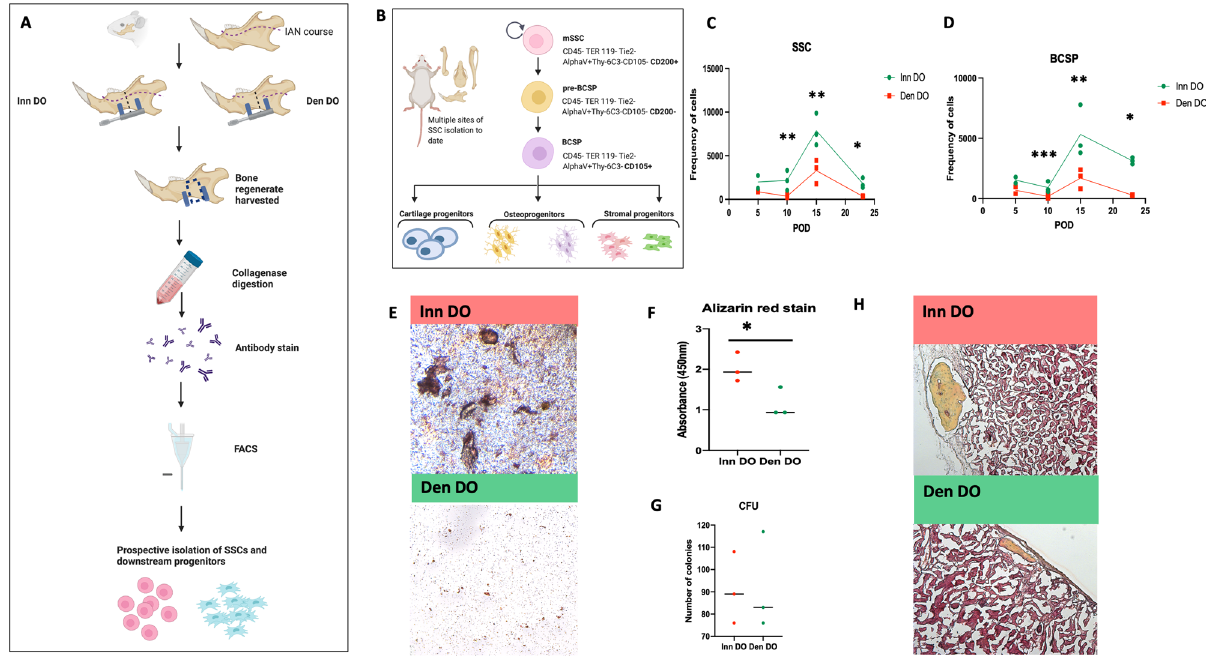
Figure 2. Mandible Skeletal Stem Cell Kinetics and Osteogenic Potential following DO are nerve dependent. ( A ) Experimental schematic: bone regenerate was harvested at multiple timepoints and cells were dissociated for FACS antibody staining and subsequent sorting / analysis. SSCs were then prospectively isolated for in vitro and in vivo analyses. Created with BioRender.com. ( B ) The mouse skeletal stem cell (SSC) is a single cell capable of giving rise to bone, cartilage and bone marrow stroma 14 and has previously been isolated from long bone 14,15 , long bone fractures 17,18 , and mandibles 12,13 . The lineage tree with relevant immunophenotypes of SSC and downstream progenitors are shown. Here, BCSP bone, cartilage and stromal progenitor. Created with BioRender. com. ( C ) Frequency of SSCs isolated using FACS from Inn DO mandibles (red) versus Den DO mandibles (green) at multiple post-operative time-points: (left to right) POD 10, POD 15, POD 23. Here * denotes p < 0.05, ** denotes p < 0.01. ( D ) Frequency of BCSPs isolated using FACS from Inn DO mandibles (red) versus Den DO mandibles (green) at multiple post-operative time-points: (left to right) POD 10, POD 15, POD 23. Here * denotes p < 0.05, ** denotes p < 0.01, *** denotes p < 0.001. ( E ) Alizarin red staining of mSSCs isolated from Inn DO (red, above) versus Den DO (green, below) and cultured in osteogenic differentiation medium to examine their in vitro osteogenic potential. ( F ) Graphical representation of the intensity (absorbance wavelength 450 nm) of alizarin red stain at POD 15 of (red) Inn DO mSSCs versus (green) Den DO mSSCs. Here * denotes p < 0.05. ( G ) Graphical representation of the colony forming unit capacity of POD 15 (red) Inn DO mSSCs versus (green) Den DO mSSCs. ( H ) Histological representation of ossicles formed 6 weeks following kidney capsule transplantation assays 14 (top, Inn DO versus bottom, Den DO) of 20,000 mSSCs isolated at POD